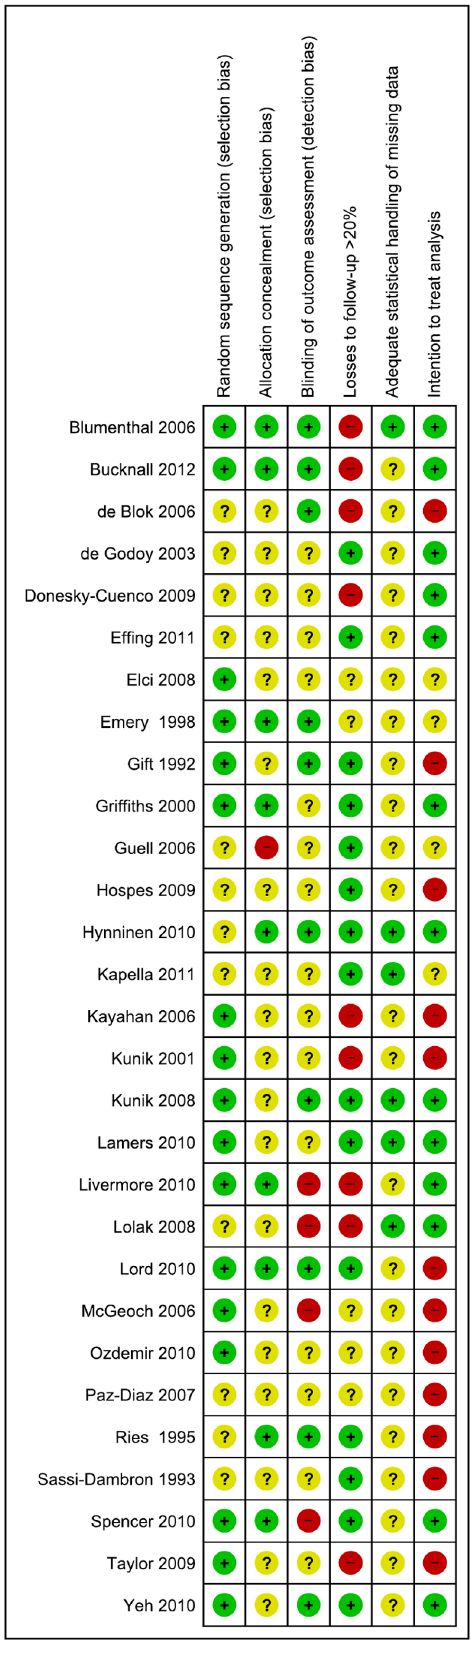
Figure 1. Risk of bias summary: review authors’ judgements about each risk of bias item for each included study.